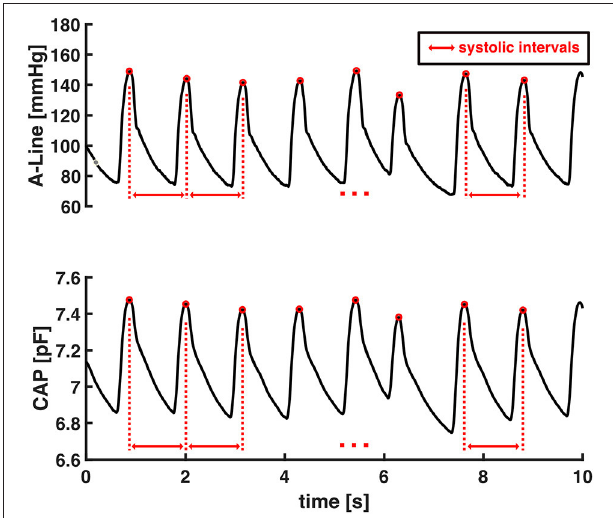
FIGURE 3 | An example of the interval of two consecutive systolic pressures used to calculate